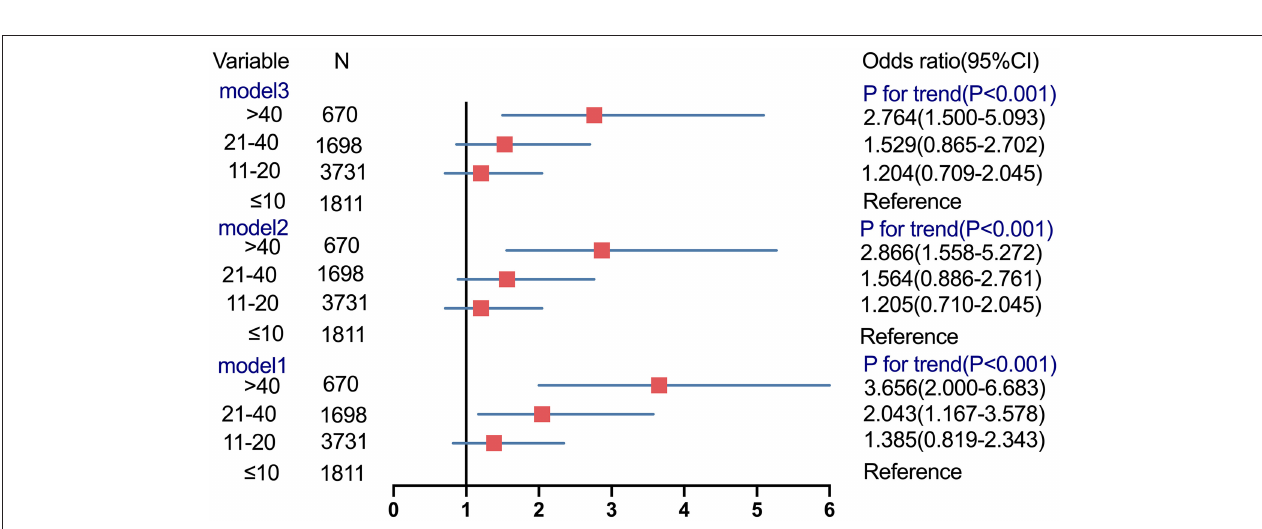
FIGURE 4 | Association between different groups of ALT and risk of cfDNA screening failures. In the group with ALT levels > 20 and 40 U/L, there was no difference in the HBV infection rate, and the NIPS test failure rate increased with increase in the ALT level, which may indicate that other diseases of pregnancy affect ALT and